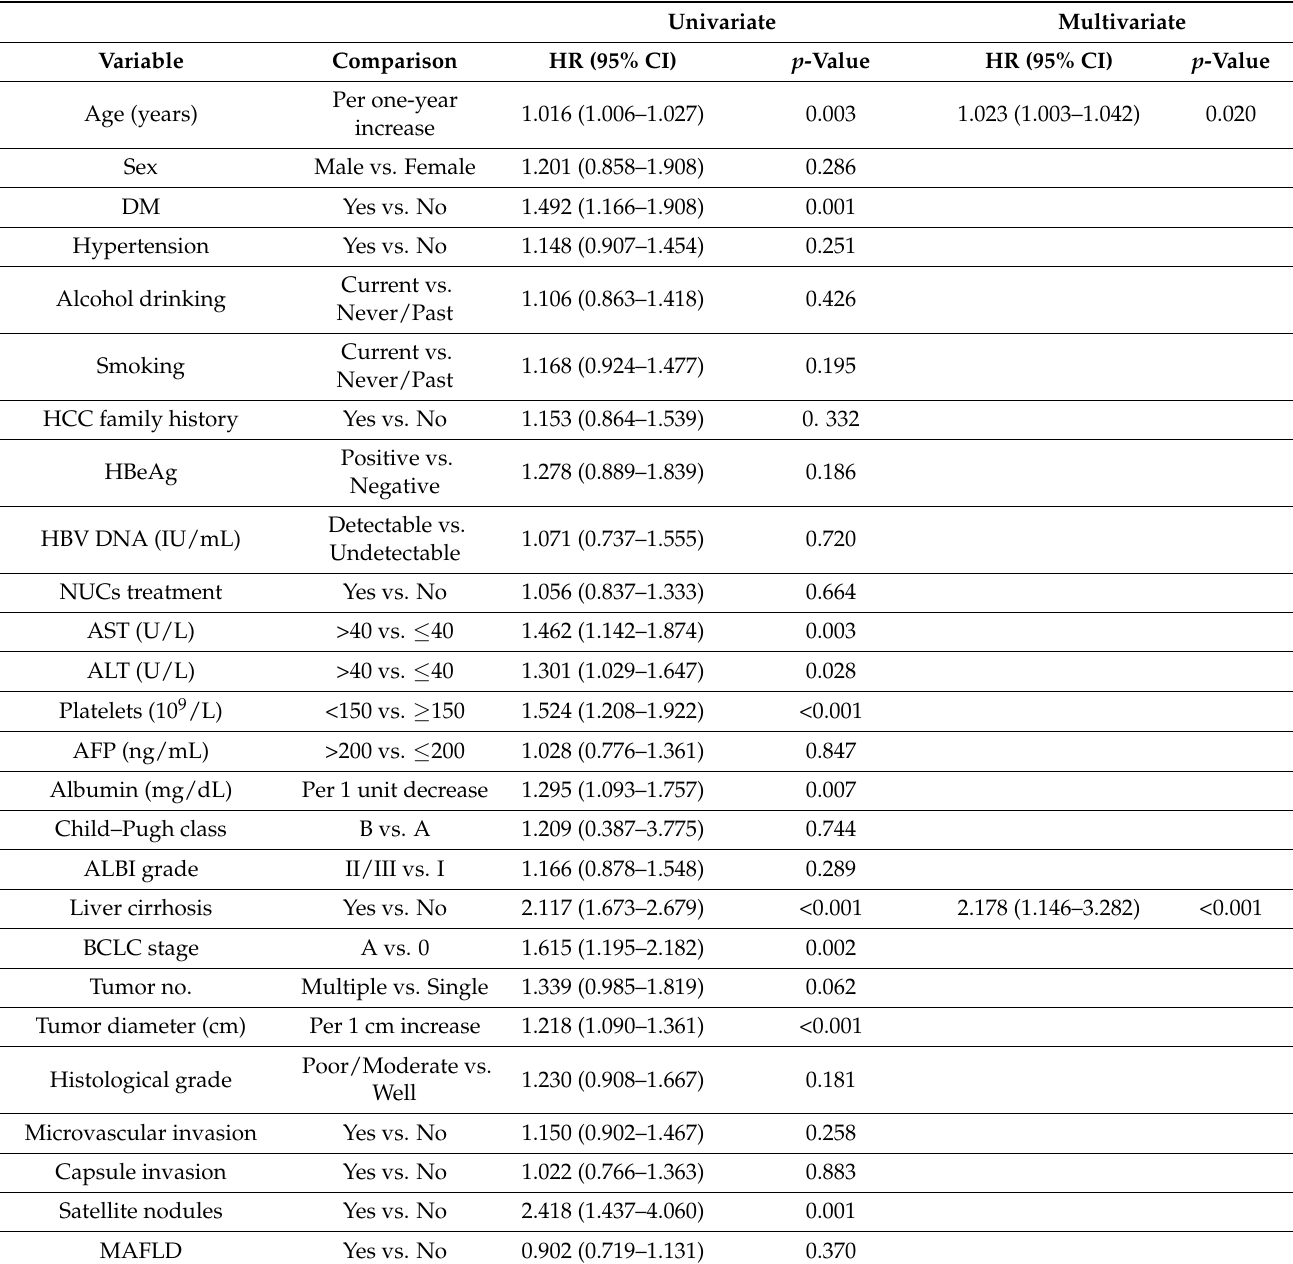
Table 2. Prognostic factors for HCC recurrence. Univariate